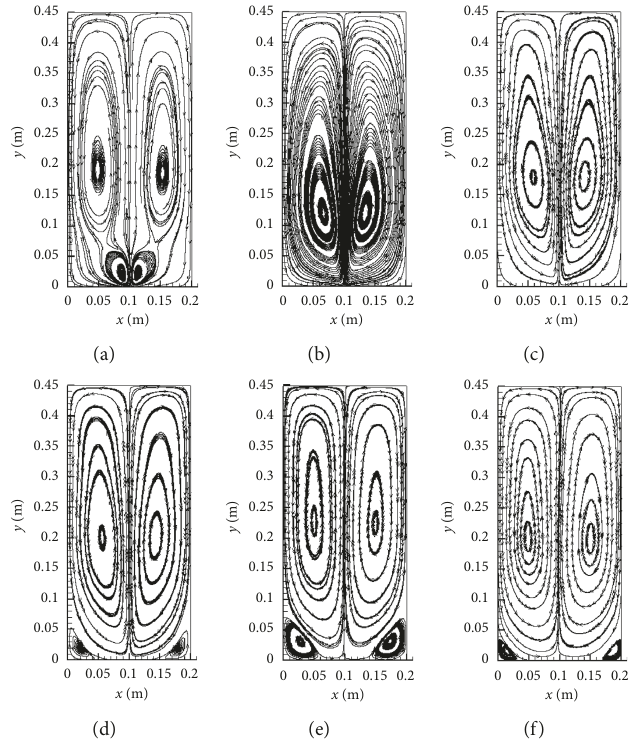
Figure 9: Instantaneous liquid flow field. (a) 160.2s, (b) 161.2s, (c) 162.2s, (d) 163.2s, (e) 164.2 s, and (f)